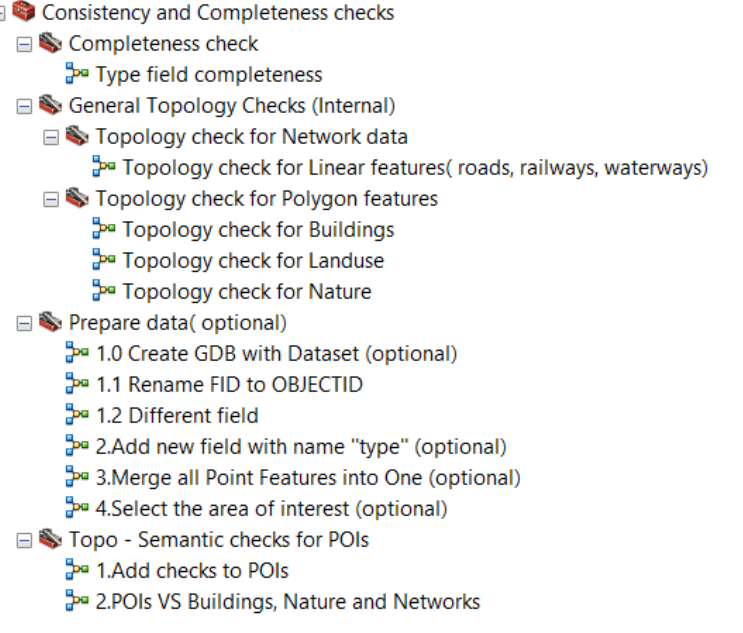
Figure 4. Consistency and completeness